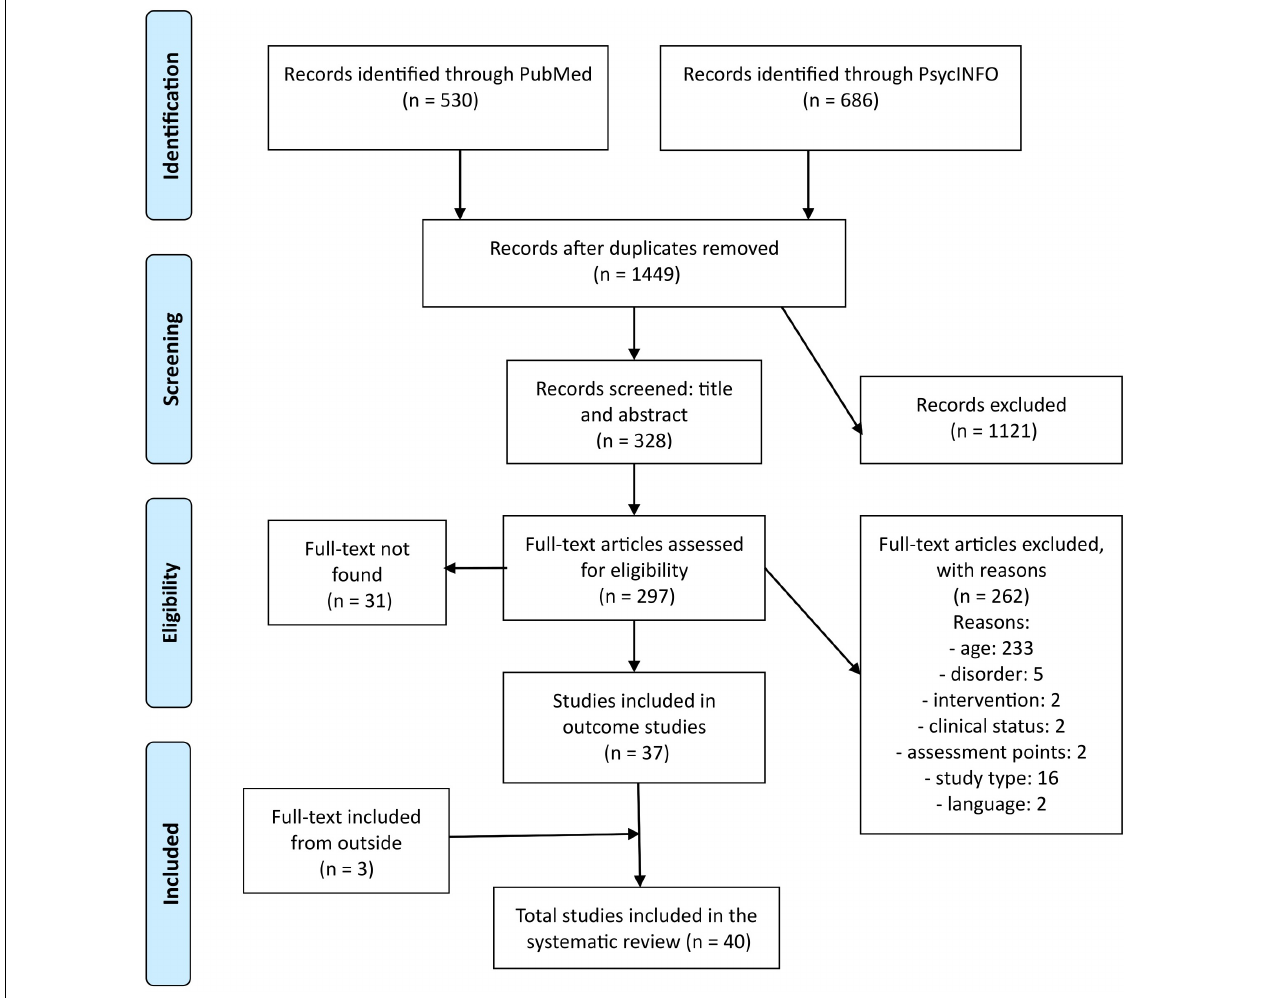
FIGURE 1 | PRISMA flow diagram detailing the number of studies retained for analysis according to screening